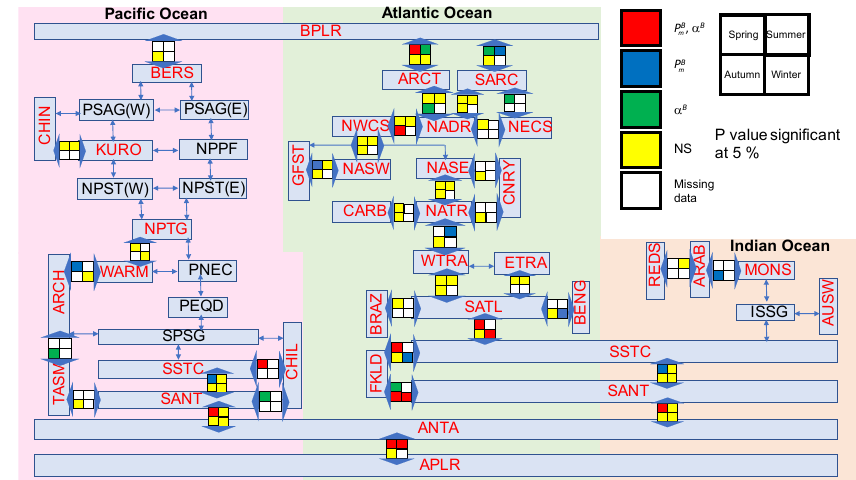
Figure 7. Diagram illustrating the seasonal differences of the P - E parameters between adjacent provinces by pairwise comparisons using Bonferroni adjusted t tests. Colours of blocks denote significance at the 5% level. Note the orientation of the four blocks representing the seasonal difference remains as shown in the legend for both vertical and horizontal comparisons.